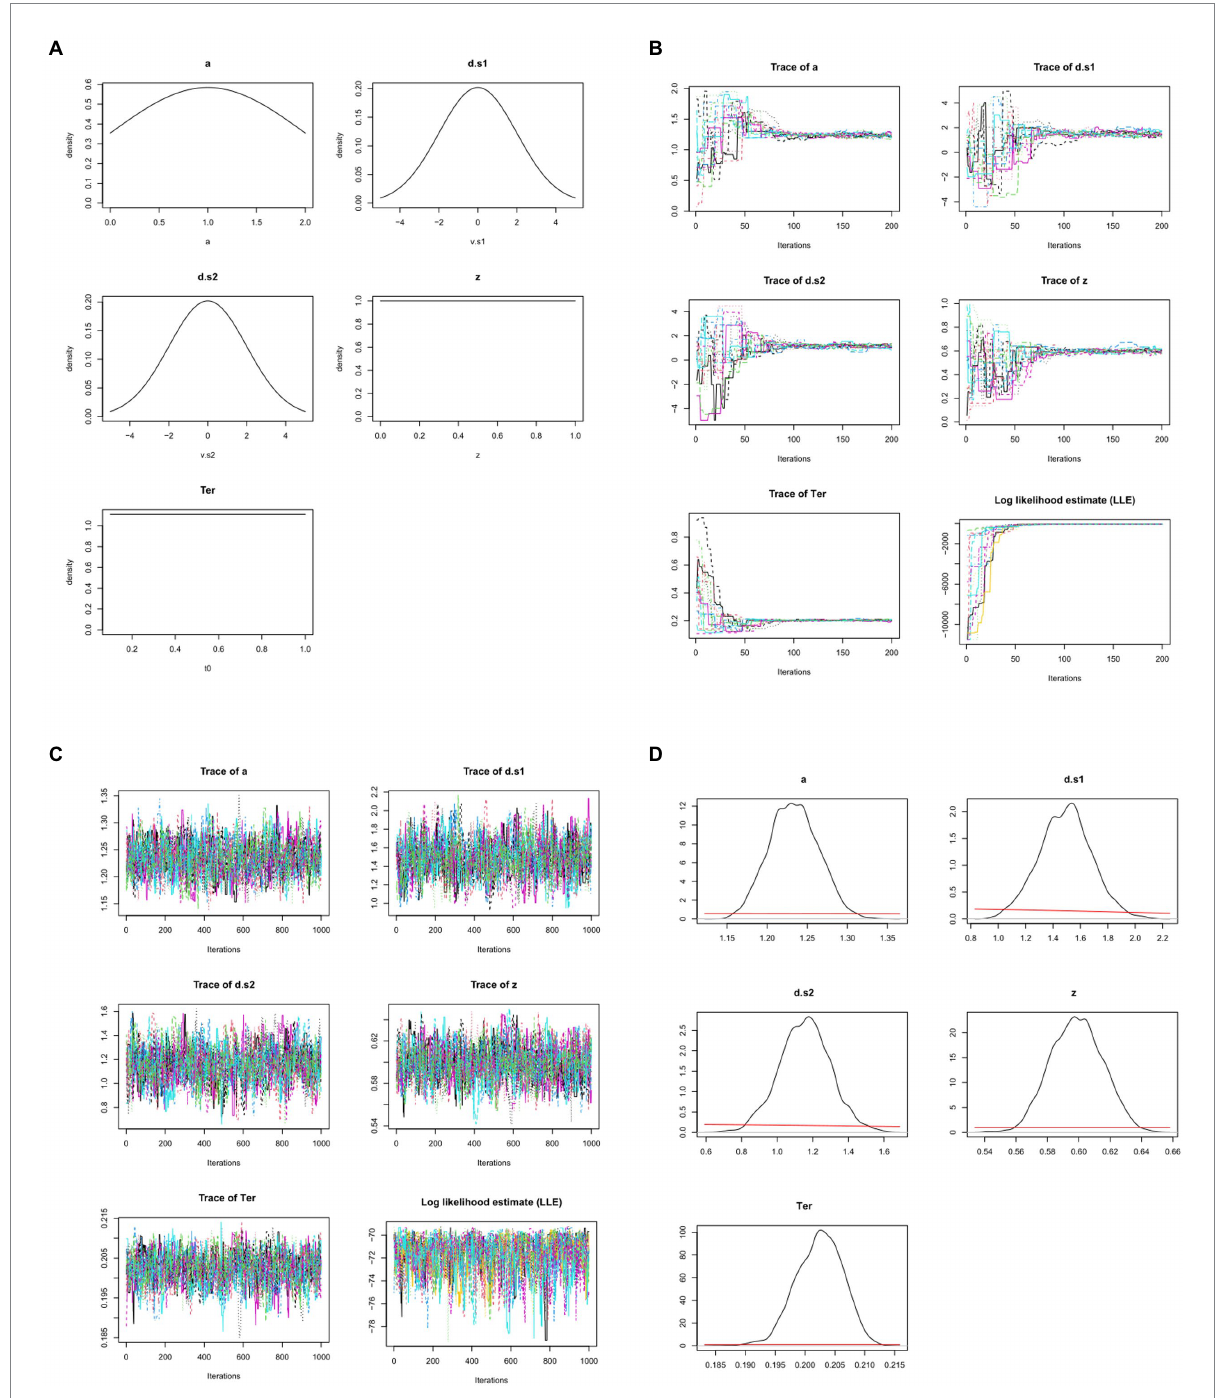
FIGURE 7 Bayesian approaches to estimating DDM model parameters. (A) First, prior distributions or “priors” (initial estimates) are generated for each model parameter. Here, the prior for non-decision time Ter simply specifies that it is a value in the range from 0.1 to 1.0 s, with all values in that range equally likely (uniform distribution); similarly, the prior for starting point z is a value in the range from 0 to 1.0 (as a proportion of boundary separation, a). The priors for drift rates are specified as broad normal distributions with means of 0; the prior for a is a normal distribution with mean of 1, truncated at 0 and 2 (because boundary separation is in arbitrary units but can never be <0). These priors are all intentionally vague, so that they have minimal influence on the posteriors. Note that, in these graphs, drift rates d.s1 and d.s2 are plotted as >0 if they slope in the direction of the correct response. (B) MCMC is applied to the dataset from Figure 4, using priors as defined in (A) : 15 “chains” are formed starting from the prior distributions and progressively updating, with model fit evaluated at each step. Traceplots of values for the 5 DDM parameters over the first 200 iterations are shown as one colored line per chain. Initially, there is wide variation across chains in the initial values drawn for each parameter from the priors; however, over the first 200 iterations, parameter values start to converge to similar values in all chains. For example,